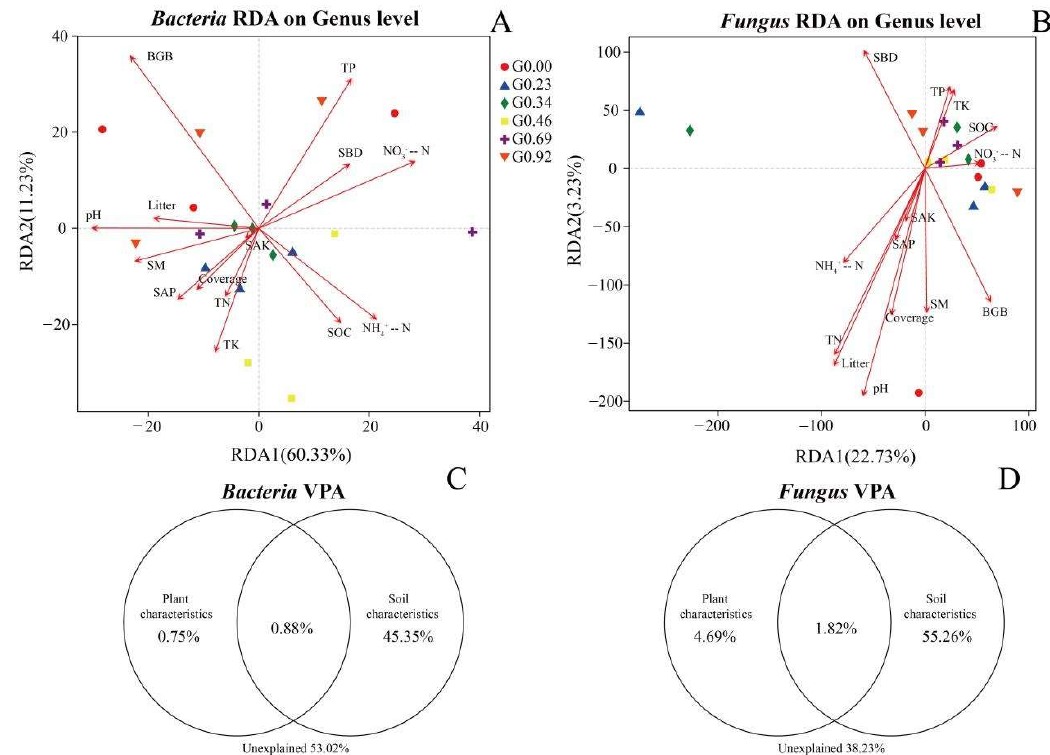
Figure 7. Redundancy analysis (RDA) of MiSeq data (symbols) and environmental characteristics (arrows) for the bacterial ( A ) and fungal ( B ) communities. Different shapes represent groups of samples under different grazing intensities. The values of axes 1 and 2 are the percentages explained by the corresponding axis. Analysis of the level of contribution of soil and plant characteristics to changes in bacterial ( C ) and fungal ( D ) communities.